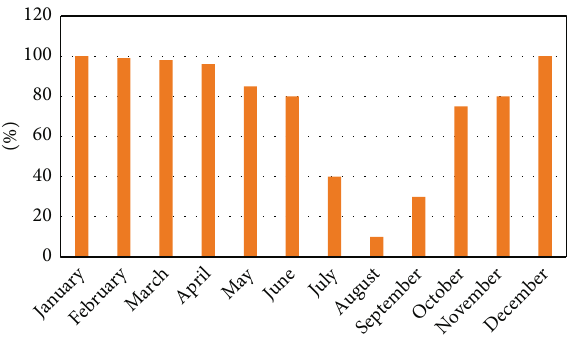
Figure 13: Performance of battery on a stand-alone